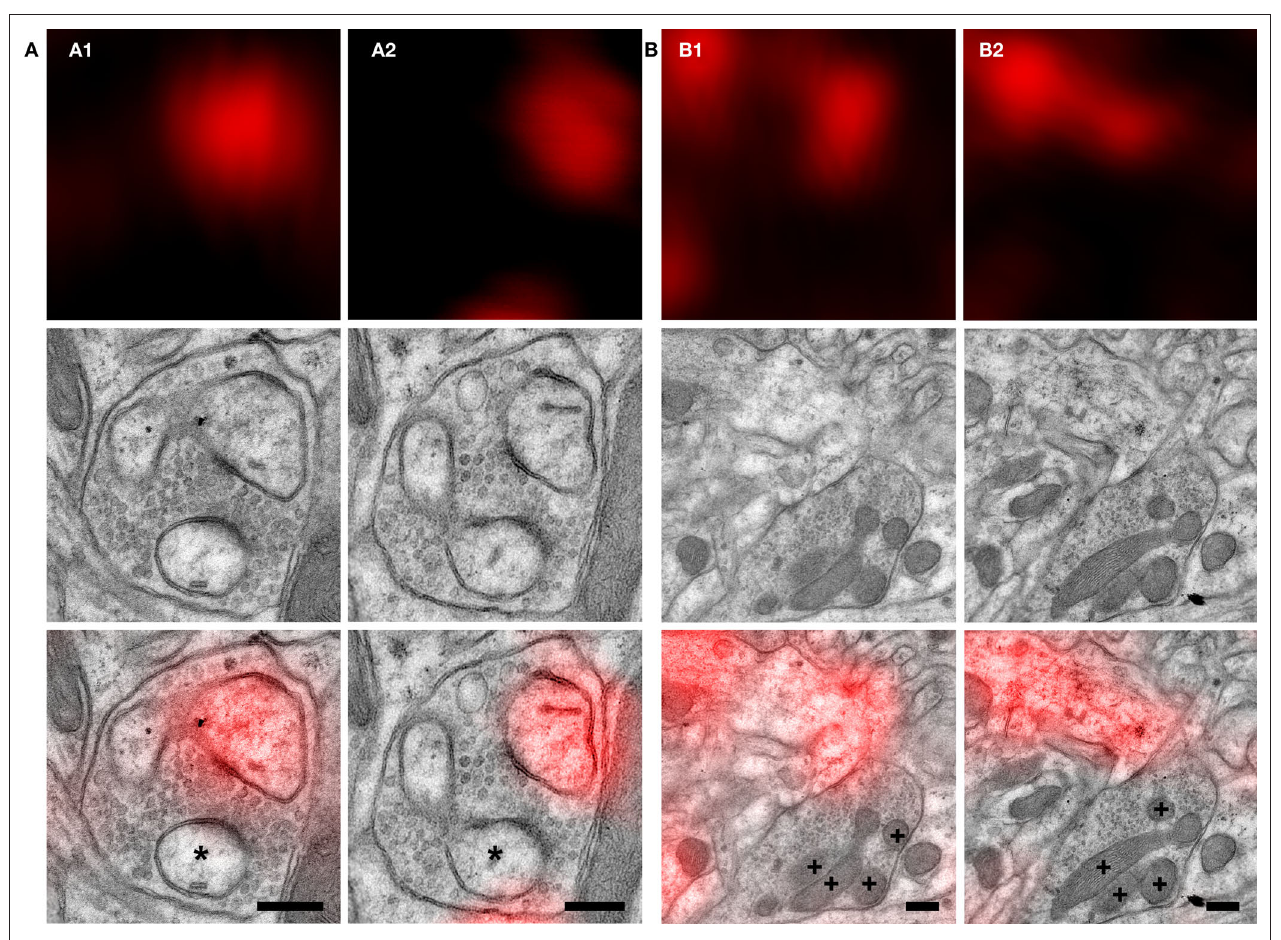
Figure 6 | High-magnification micrographs of two synapses made by labeled neurons. Both synapses (A,B) were imaged in two consecutive ultrathin sections ( A1 and A2, B1 and B2 , respectively). Top row: light micrographs. Middle row: electron micrographs. Bottom row: superposition of LM and EM images. Fluorescence signal overlaps with a post-synaptic compartment and is consistent for this region between the two consecutive